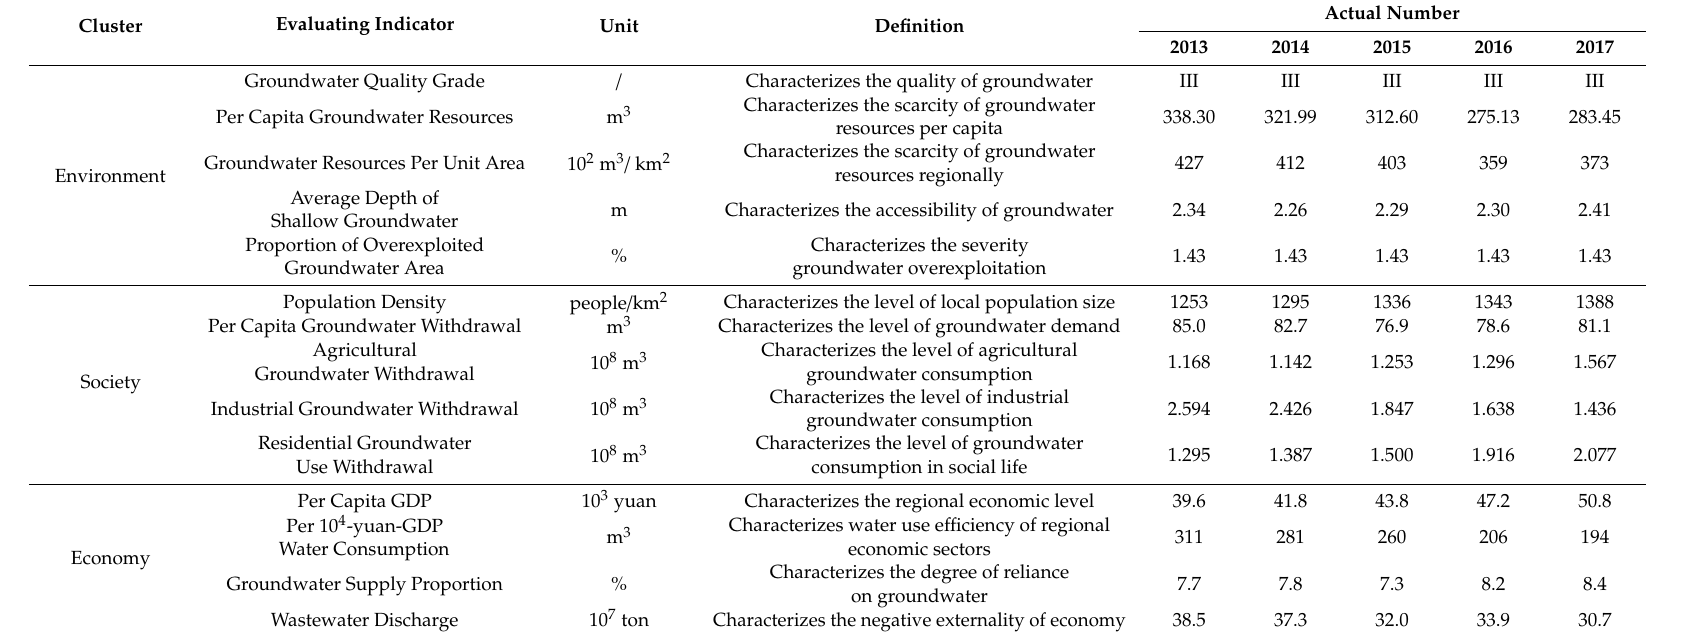
Table 3. Groundwater rights value evaluation indicators for